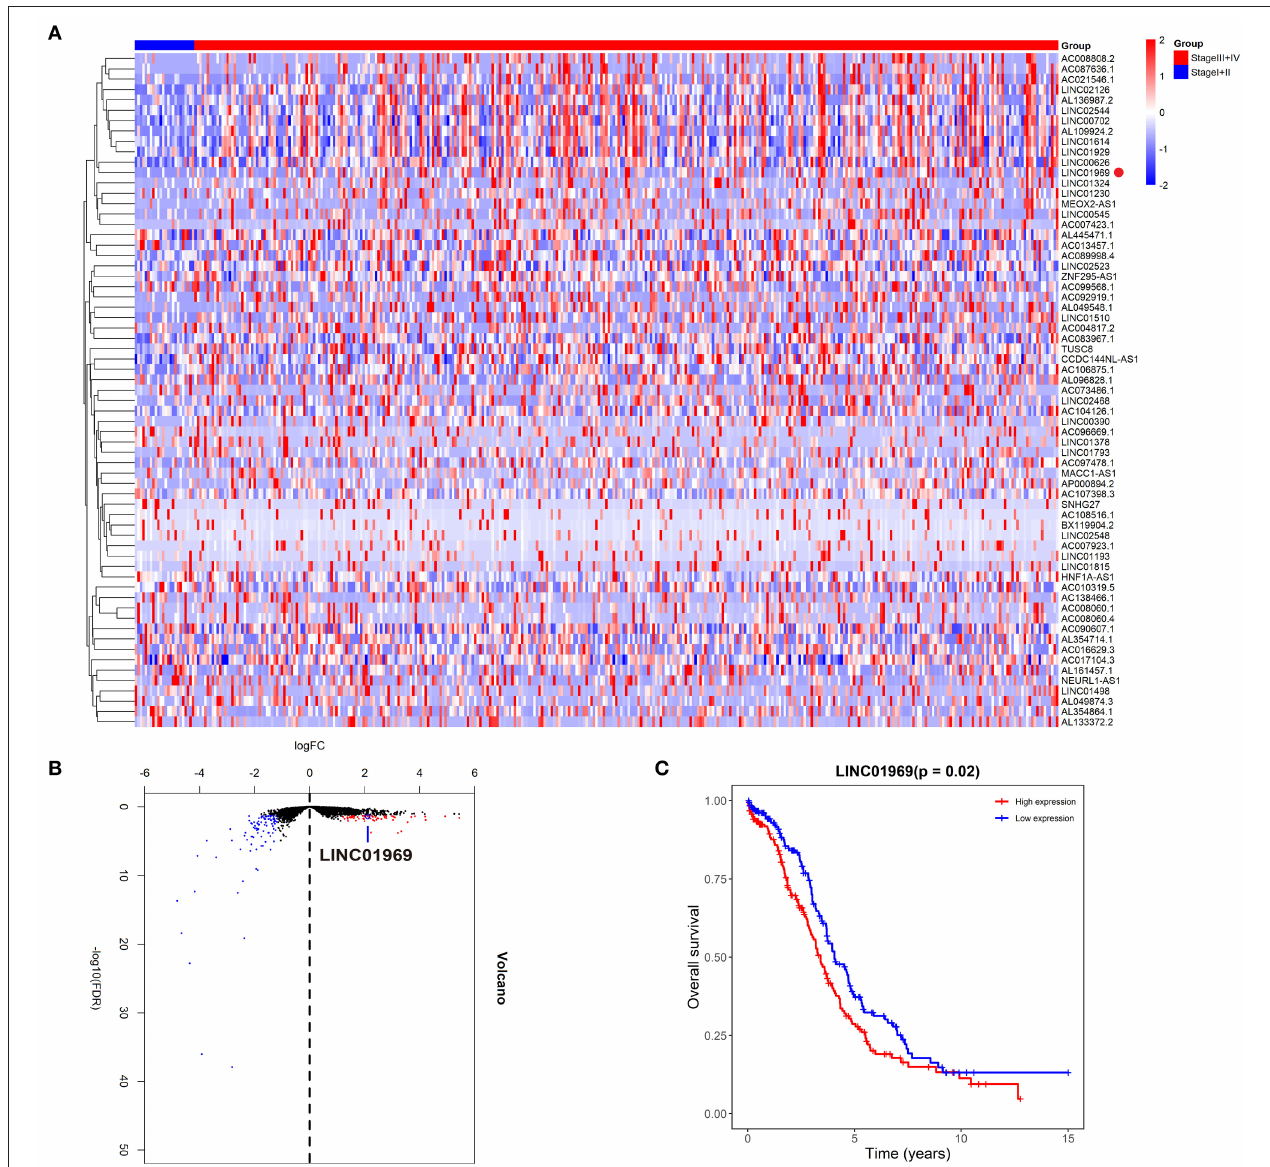
FIGURE 1 | Upregulated LINC01969 correlates with unsatisfactory prognosis of ovarian cancer (OC) cases revealed by The Cancer Genome Atlas (TCGA) database. As per the Neoplasm American Joint Committee on Cancer Clinical Group Stage, we allocated OC tissues into stage I + II group and stage III + IV group. (A,B) The heat and volcano maps revealed all differentially expressed long non-coding RNAs (lncRNAs) of OC tissues in the TCGA database with log2FC > 2 or < − 2, P < 0.05. (C) Kaplan–Meier survival analysis of LINC01969 expression in OC tissues from TCGA database.